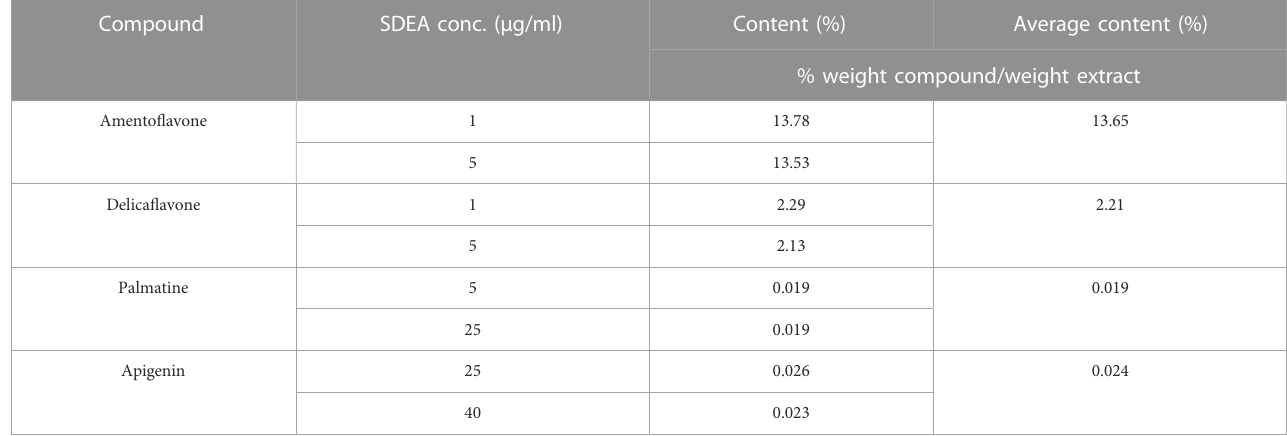
TABLE 1 Contents (% w/w) of the four constituents in SDEA. (Higher SDEA concentrations were used because Apigenin and Palmatine are less in SDEA).